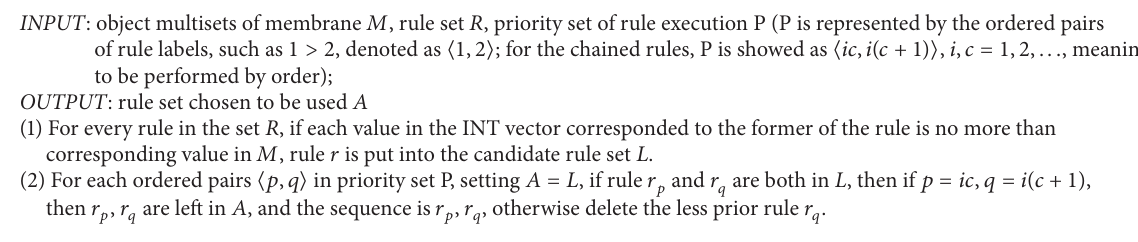
Algorithm 2: Rule selection algorithm for simulation of P chain system.